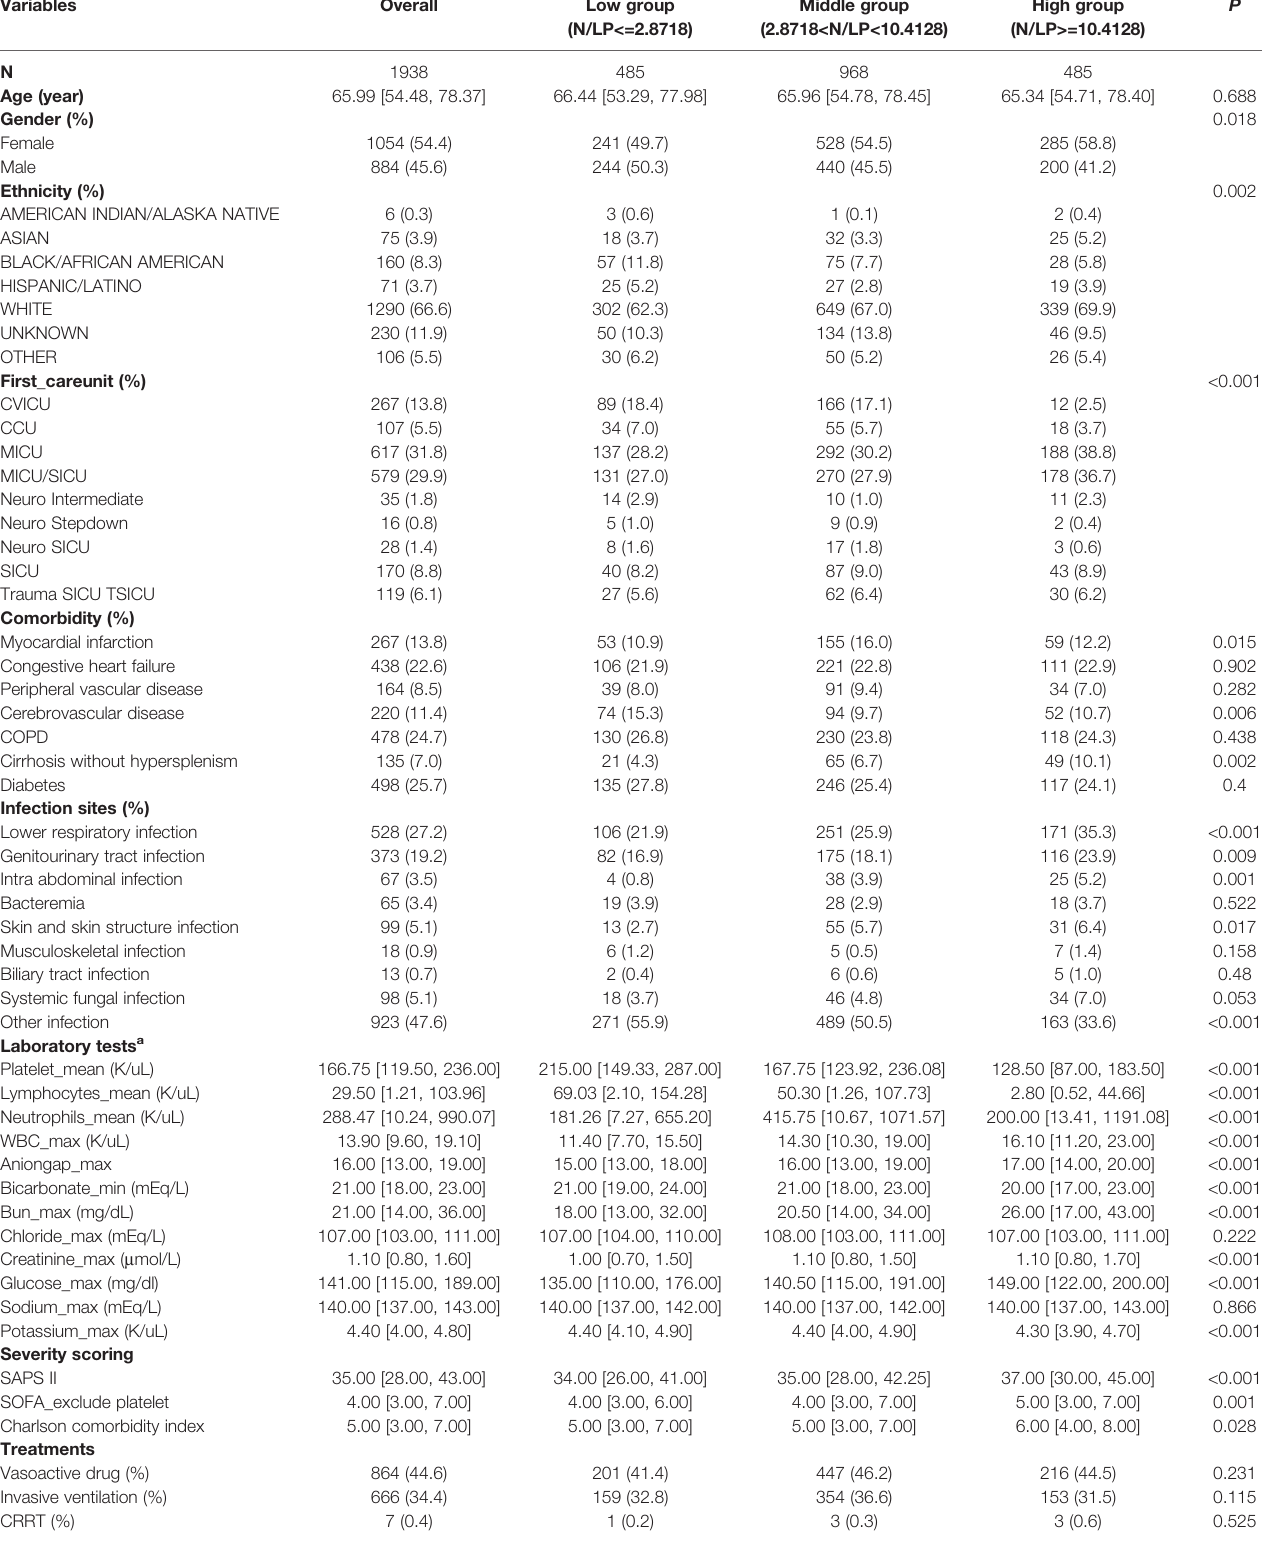
TABLE 1 | Baseline demographic and clinical characteristics by different N/LP level in sepsis